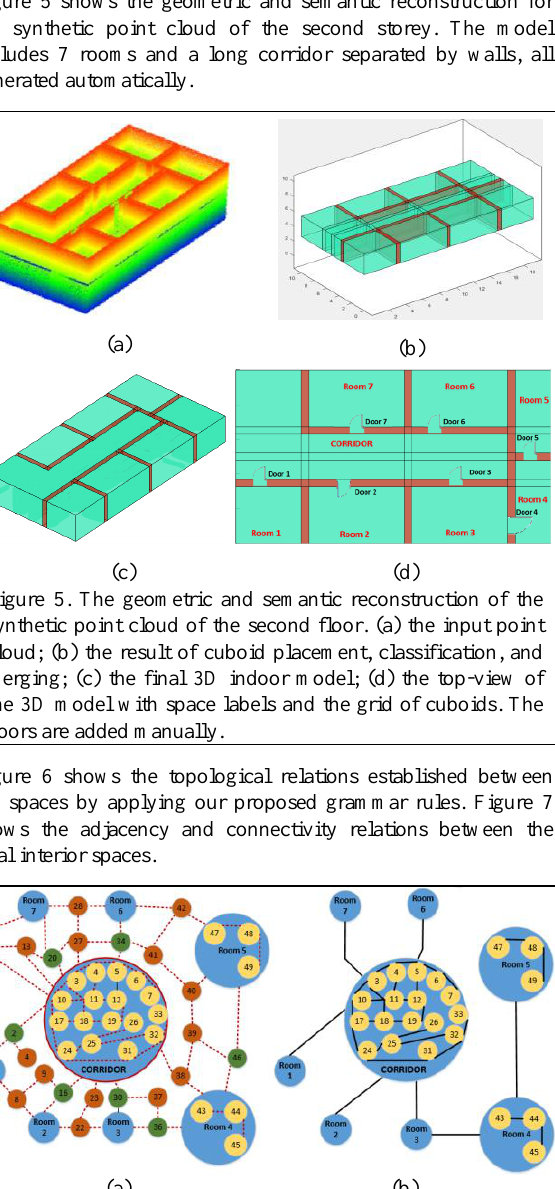
Figure 7. Dual graph representing the connectivity relations (black solid lines) and adjacency relations (red dashed lines) reconstructed for the second storey of the synthetic point cloud.